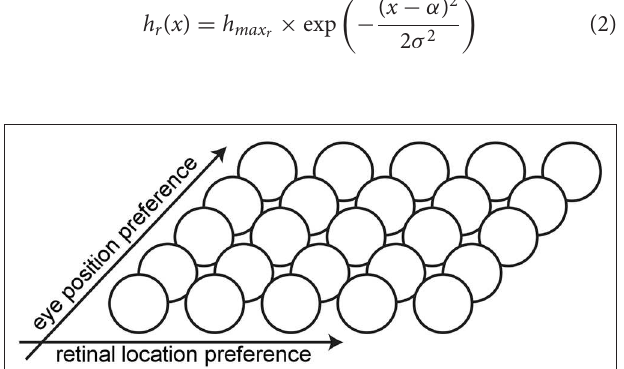
FIGURE 1 | Architecture of the hardwired neural network model. The architecture of the hardwired neural network model consists of a single layer of visual output neurons. Each neuron is set to respond maximally to a unique combination of eye position and retinal location of the visual stimulus.